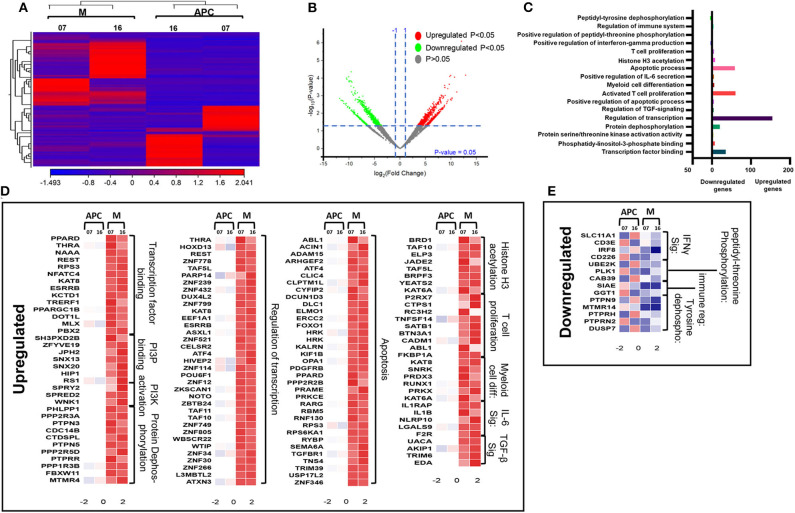
Comparative analyses of gene expression between M-MDSCs and monocytic APCs in the circulation of CRC patients. Hierarchical clustering of M-MDSCs and monocytic APCs from two patients (07 and 16) on differentially expressed transcripts. Gene expression level is illustrated as a color code (A). Volcano plot illustrates the differential expression data, represented as log2 fold change on the x-axis, with the statistical impact on the y-axis. Fold changes with significant P values (>0.05) are highlighted in red (for upregulated genes) and green (for downregulated genes) (B). Functional categorizations for significantly upregulated and downregulated transcripts were analyzed on DAVID platform. Bar diagram illustrates the percentage of genes in each functional category (C). Heat maps show the Z score of the upregulated (D) and downregulated (E) transcripts in M-MDSCs, compared with monocytic APCs, based on their functional categorization.